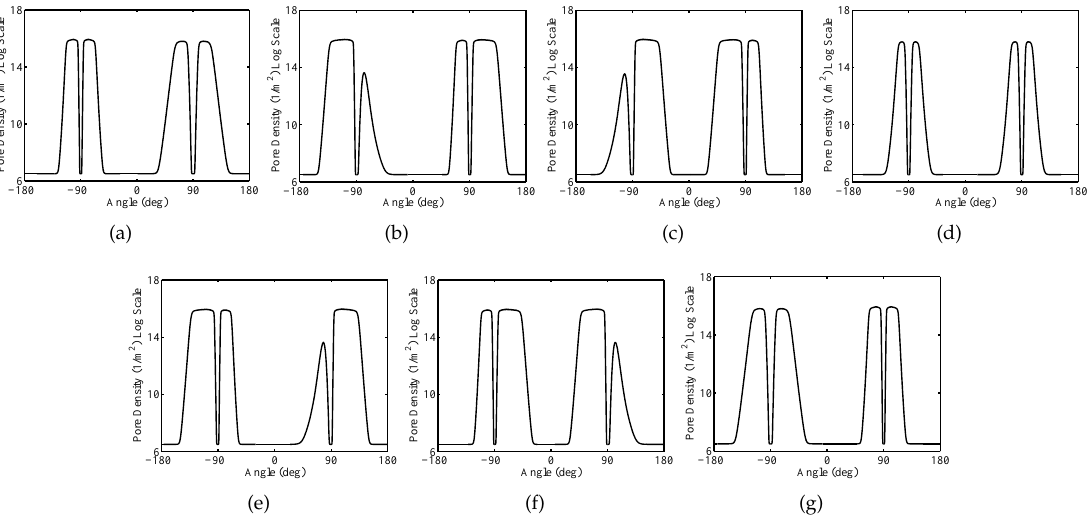
Figure 6. Packed System—Plasma membranes pore density versus the polar angle at time instant t = 20 ns for ( a ) cell 1, ( b ) cell 2, ( c ) cell 3, ( d ) cell 4, ( e ) cell 5, ( f ) cell 6, ( g ) cell 7. Pulse amplitude and duration equal to 100 kV/cm and 10 ns, respectively.